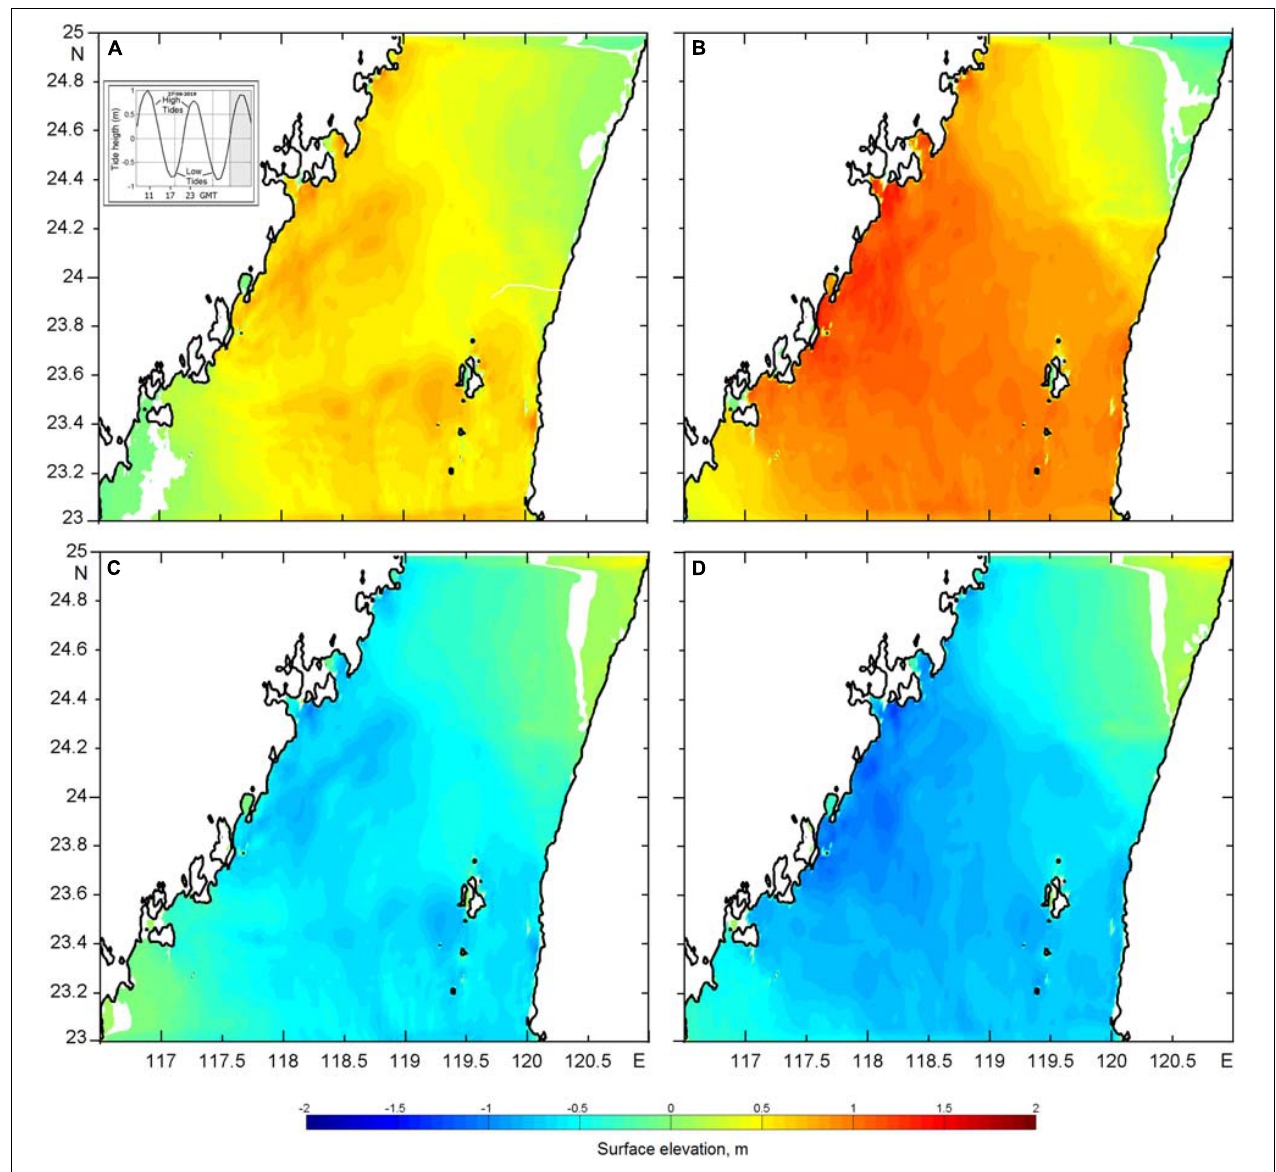
FIGURE 3 | Successive phases of distribution of the sea surface elevation at (A) 09:30, (B) 11:00 (max flood elevation), (C) 15:30, and (D) 17:00 (max ebb elevation) on June 27, 2013, within the entire model domain indicating the water level during the tide transition from the ebb to the flood. The inset ( Figure 3A ) presents the sea surface elevation during June 27–28,